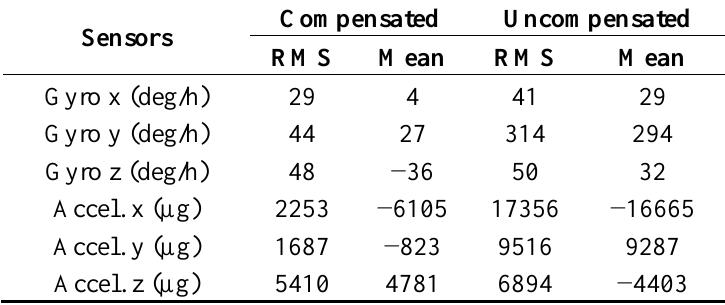
Table 11. Statistical results of NV-IMU100 output errors with and without compensation.